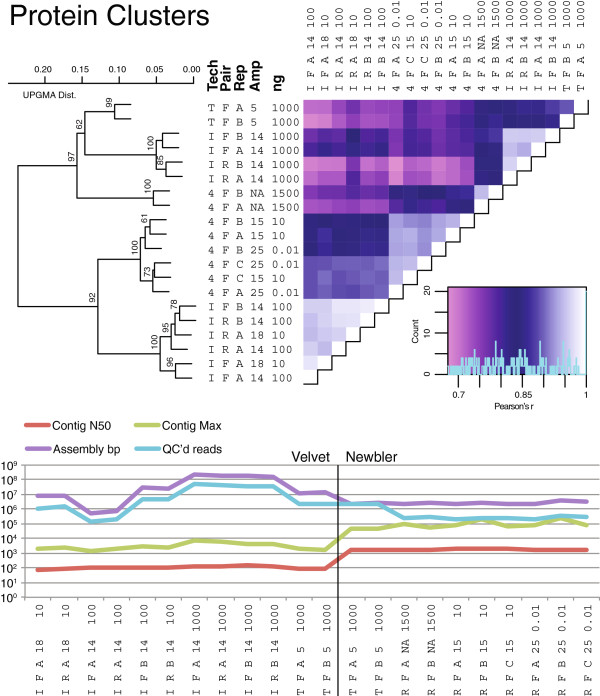
Protein cluster functional analysis and assembly statistics for Experiment 1 metagenomes. Metagenomic reads were mapped to POV protein clusters (see text) and hit frequencies were used to produce pairwise correlation heat maps. Details as described in Figure 2, including bootstrap analysis of statistical support for correlations across metagenomes. Assembly performance of each sample across the dataset was evaluated using metrics of n50 and maximum contig size, as well as the number of reads and base pairs that were assembled. Note that inferior assembly performance was restricted to samples with reduced read yields. Lastly, the Newbler assembler yielded larger contigs and smaller total assemblies when compared to Velvet assembly of the same Ion Torrent dataset.